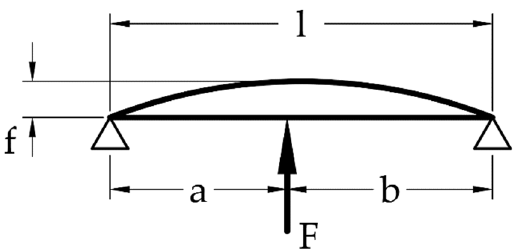
Figure 6. Static scheme of the beam loaded